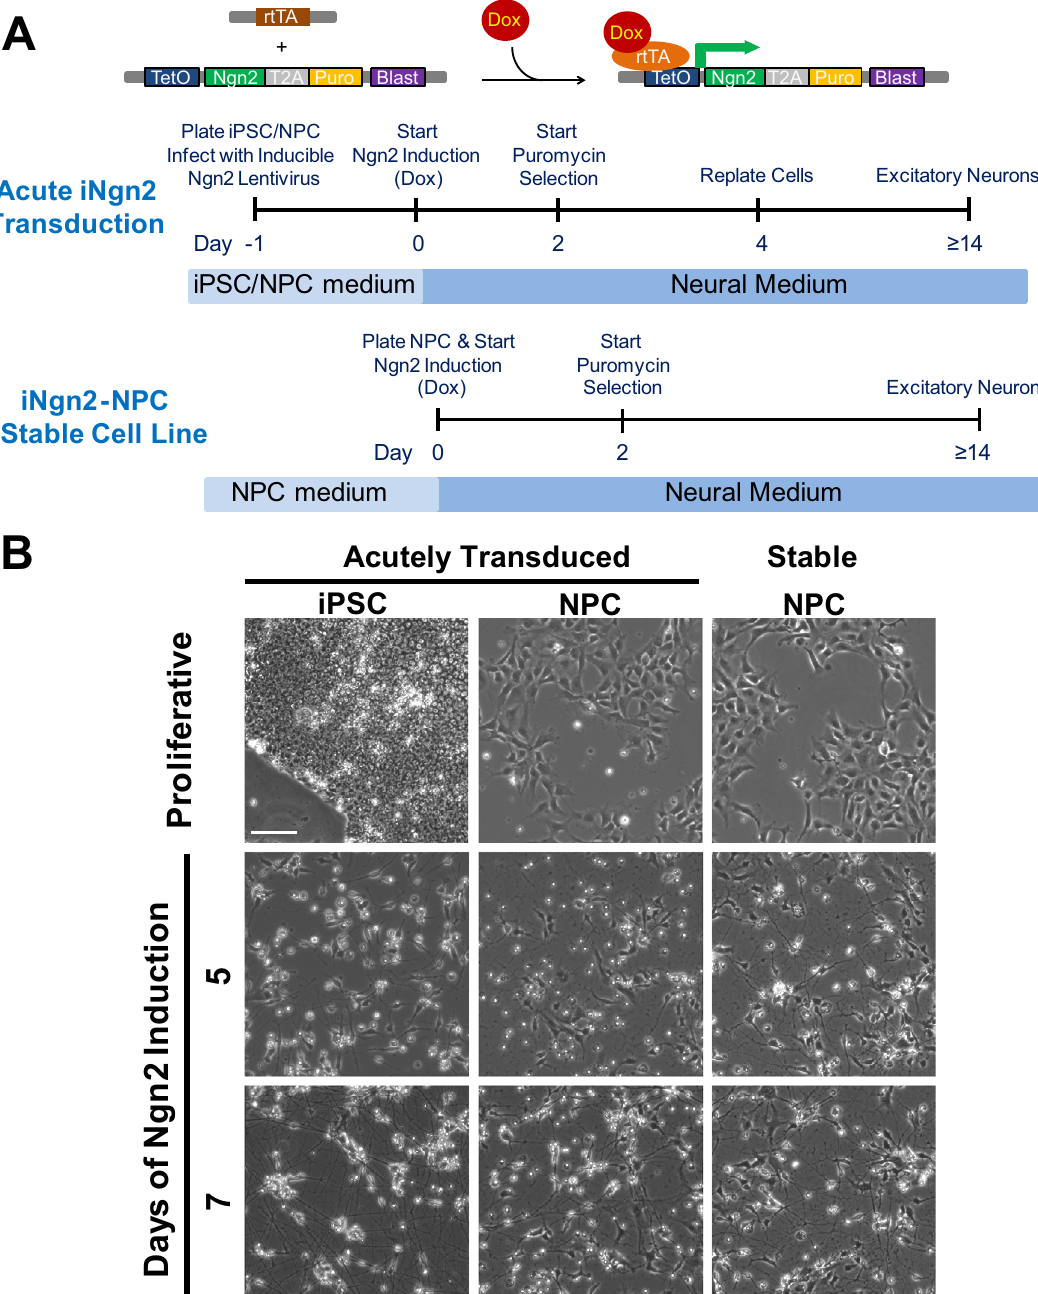
Figure 1. Schematic of the methodology and morphology of iNgn2 neurons. ( A ) Top panel illustrates the action of the transgenes in inducing the expression of Ngn2 in generating the iNgn2 neurons. The addition of doxycycline (Dox) results in the binding of Dox to the transactivator (rtTA) expressed of a constitutively active human ubiquitin C promoter, changing the conformation of rtTA to promote binding of the rtTA-Dox complex to the inducible TetO promoter, thereby activating the expression of Ngn2 and the puromycin (Puro) resistance marker. Stable cell lines were generated before neuronal induction with the use of the constitutively expressed blasticidin (Blast) resistance selective marker. The bottom two panels contain the timeline of iNgn2 neuron generation either by acute transduction of the Ngn2 lentivirus or induction of Ngn2 in an iNgn2-NPC stable cell line. Human iPSC or NPC were plated and transduced with the Ngn2 lentivirus at day -1 in the acute transduction method. Neuronal induction was started at Day 0 with the addition of Dox. Transduced cells were selected at Day 2 with the addition of Puro. Optionally, puro-selected iNgn2 cells can be replated at a desired density at Day 4. By Day 14, predominantly excitatory glutamatergic neurons are generated. ( B ) Phase contrast images of live iNgn2 neurons at various time points of Ngn2 induction. Scale bar represents 100